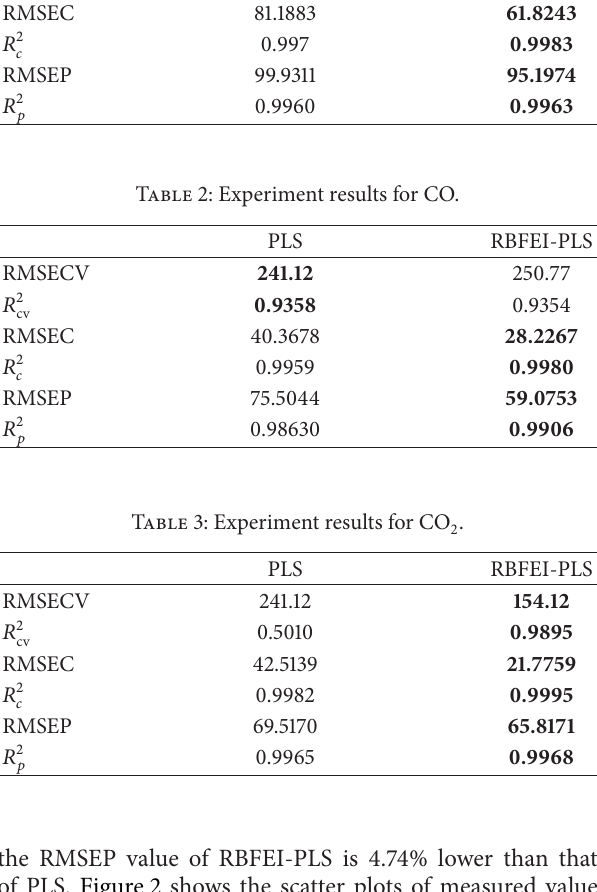
Table 1: Experiment results for CH